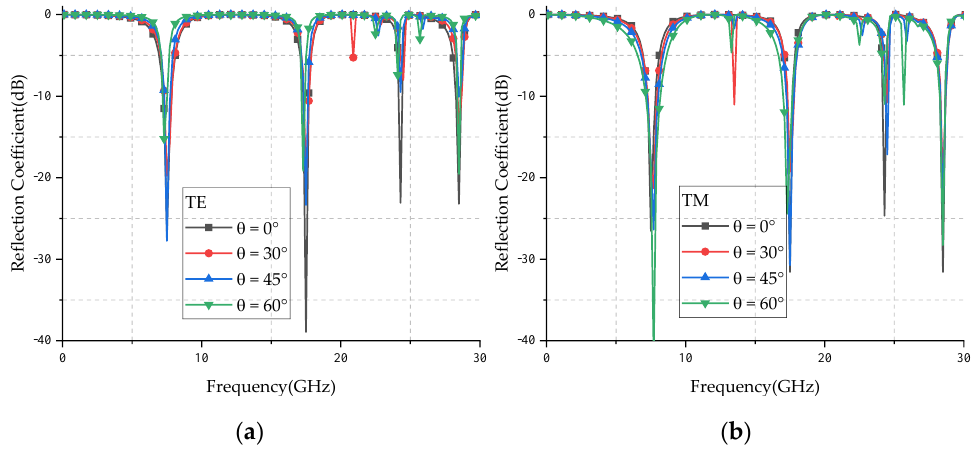
Figure 10. Simulated reflection coefficients for various oblique angles of incidence: ( a ) TE polarization; ( b ) TM polarization.